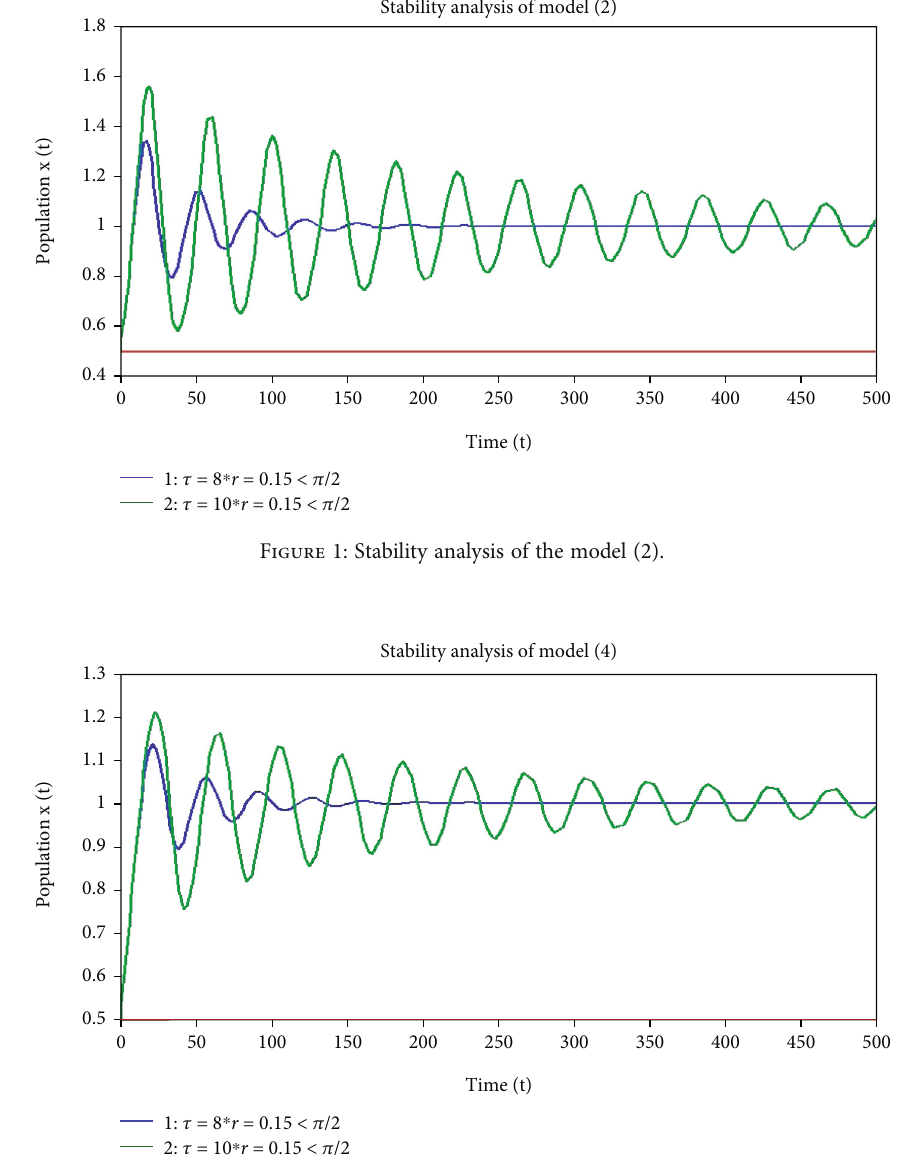
Figure 2: Stability analysis of the model